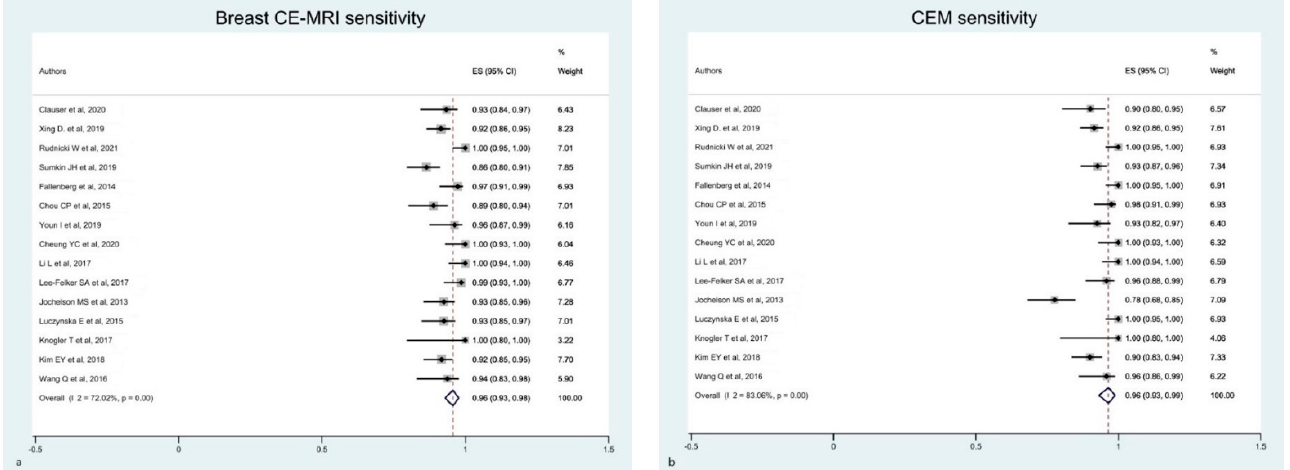
Figure 2. Forest plot of the estimated pooled sensitivity of breast CE-MRI ( a ) and CME ( b ) in the detection of pathological breast lesions, including index and secondary lesions. The estimated pooled sensitivity of CE-MRI ( a ) was 0.96 (95% CI 0.93 – 0.98), with a moderate heterogeneity (I 2 = 72.02% p = 0.001). The estimated pooled sensitivity of CME ( b ) was 0.96 (95% CI 0.93 – 0.99), with a high heterogeneity (I 2 = 83.06% p = 0.001) [16,17,18,19,21,22,23,24,25,26,28,29,30,33,34].